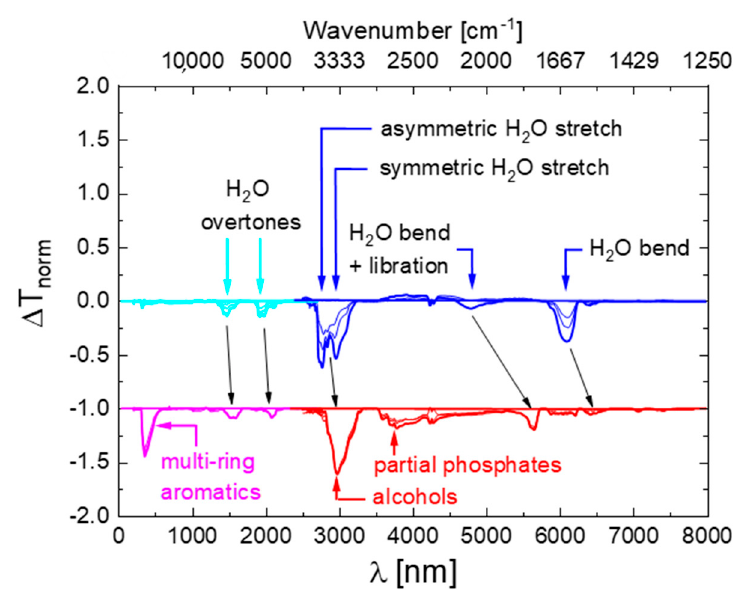
Figure 4. Di ff erence spectra as obtained on Skydrol LD4 after controlled contamination with water (top row) and after water contamination and molecular fragmentation (bottom